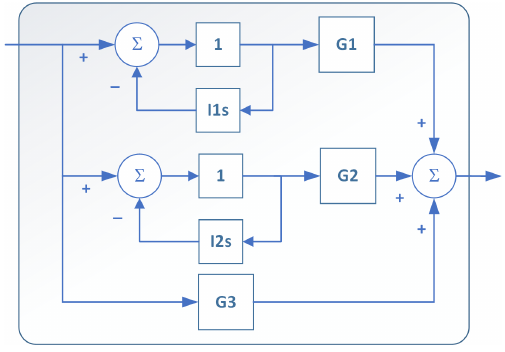
Figure A2. Block diagram representing the equivalence (A2). Table A2. Parameter values for the electrical circuit with OPAMs of Figure